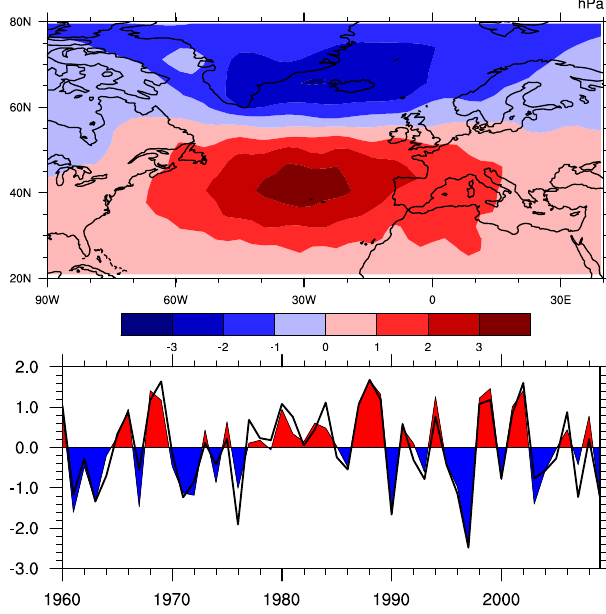
Fig. 4. Top: leading empirical orthogonal function (EOF1) of the winter (December–February) mean sea level pressure (SLP) anoma- lies in the North Atlantic sector (20 ◦ –80 ◦ N, 90 ◦ W–40 ◦ E) which explains 38% of the total variance. The pattern is displayed in terms of amplitude (hPa), obtained by regressing the SLP anomalies on the principal component time series. Bottom: principal component time series (red, blue) of the leading EOF plotted with the modeled NAO index (black) based on the normalised SLP difference be- tween Ponta Delgada, Azores, and Stykkish´olmur/Reykjav´ık, Ice- land. The correlation coefficient is